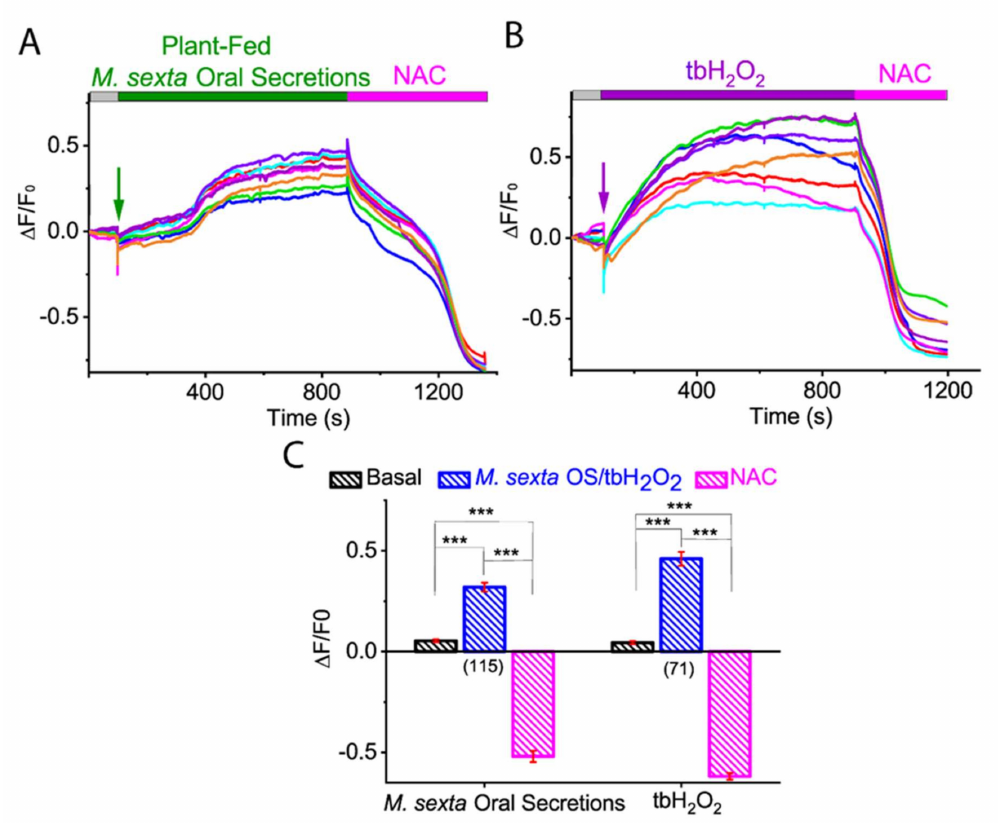
Figure 4. E ff ect of antioxidant NAC on M. sexta OS and oxidant tbH 2 O 2 -induced ROS production in tomato protoplasts. Representative ROS imaging of the isolated tomato protoplast with the application of PF M. sexta OS ( A ) and tbH 2 O 2 ( B ), followed by the application of antioxidant NAC. ( C ) Bar graph analysis of data shown in ( A , B ) illustrating the maximum ROS generation after PF M. sexta OS and tbH 2 O 2 application and the minimum ROS level after NAC application. Statistical indicators reflect the non-parametric Kruskal-Wallis test followed by Dunn’s pairwise post hoc comparisons, testing for an e ff ect of PF M. sexta OS, tbH 2 O 2 , and NAC on the ROS level in the isolated protoplasts: *** p < 0.0001. Di ff erent color traces in the graph ( A , B ) reflect the OS-induced ROS response in individual protoplasts from a single replicate. The number of protoplasts ( N ) from 3–5 independent measurements are provided in parentheses in ( C